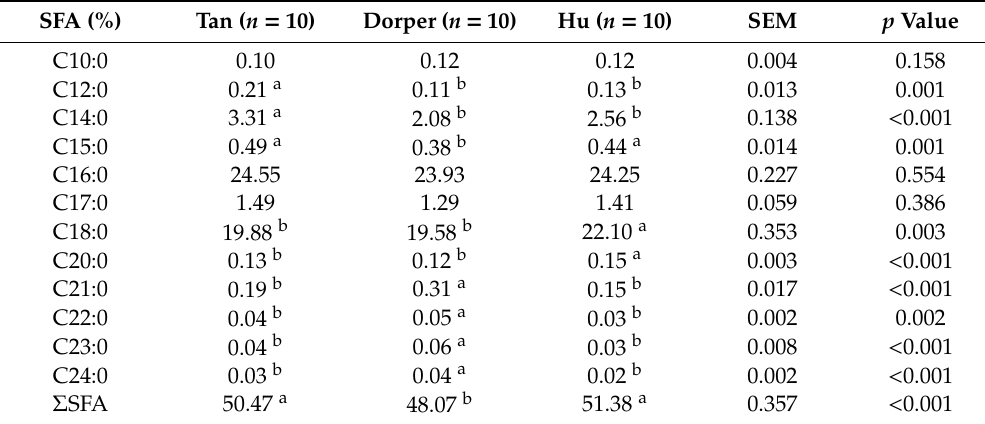
Table 3. E ff ect of breed on saturated fatty acid (%) of LTL.